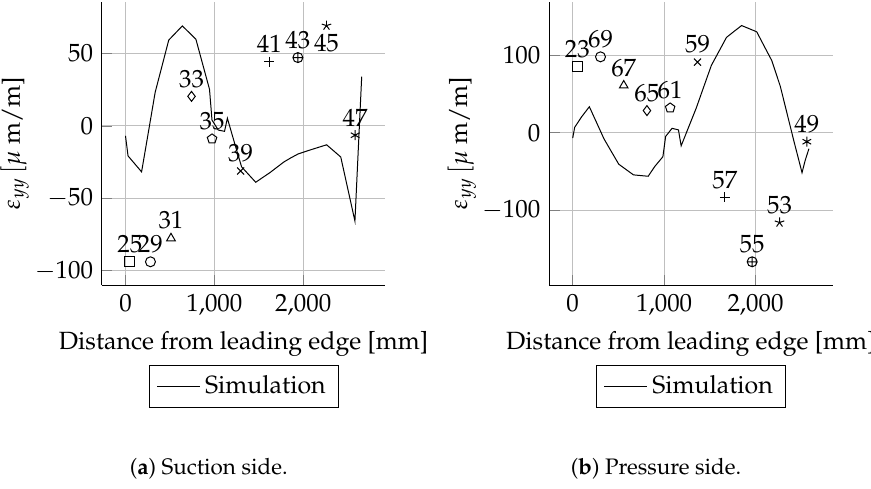
Figure A59. Strain comparison ε TT at radial position R = 5000mm for torsion load case